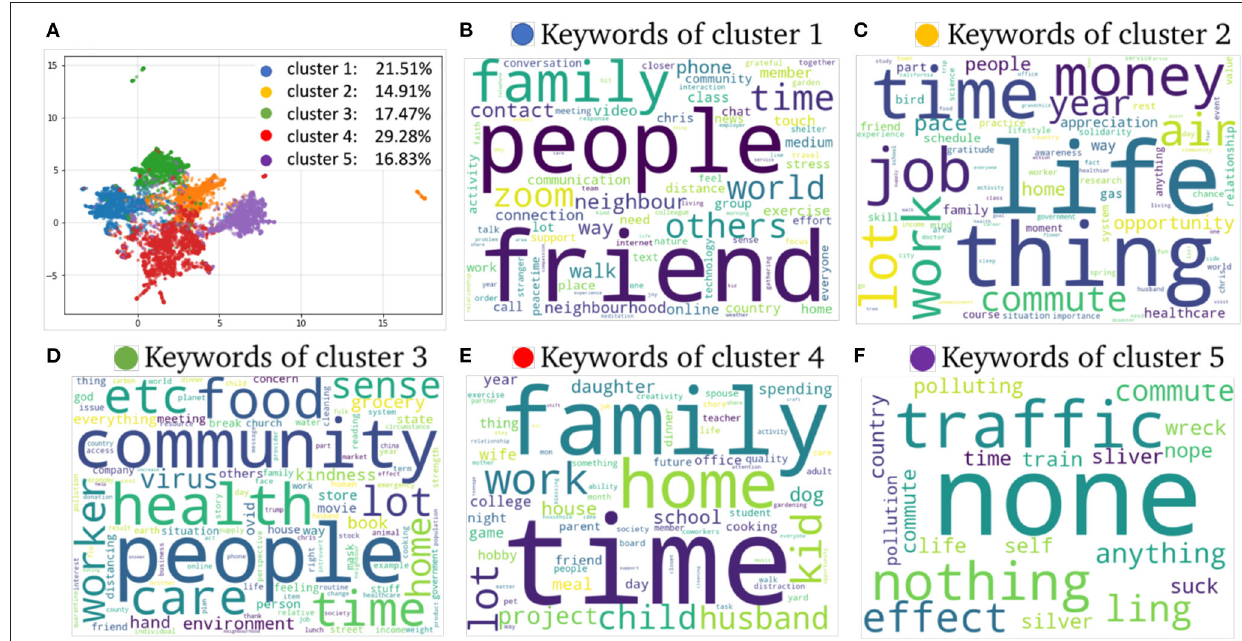
FIGURE 3 | Clustering and most frequent words from free-text responses based on the combination of LDA and BERT embeddings methods. (A) Shows the clustering considering 5 clusters (groups) as main topics. Each cluster shows the percentage of number of responses in that group, for instance, cluster 5 contains 16.83% of the total of responses, and (F) presents keywords from cluster 5 associated with positive environmental impact, benefits of working from home.